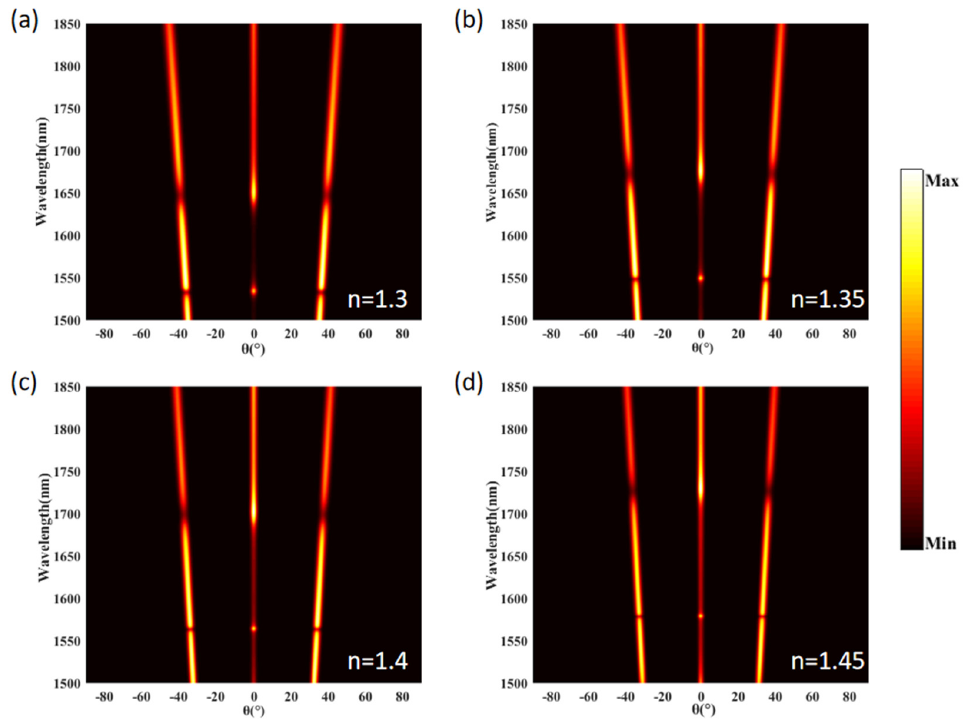
Figure 9. ( a ) Total transmission, reflection, and absorption spectra of the proposed metasurface with n = 1.3. ( b ) The intensities of T L , T R , and T C for the range of 1500–1850 nm with n = 1.3. ( c ) The anom- alous transmission intensity of the proposed structure with different refractive indices. ( d ) Reflec- tion spectra of the proposed design with different refractive indices.